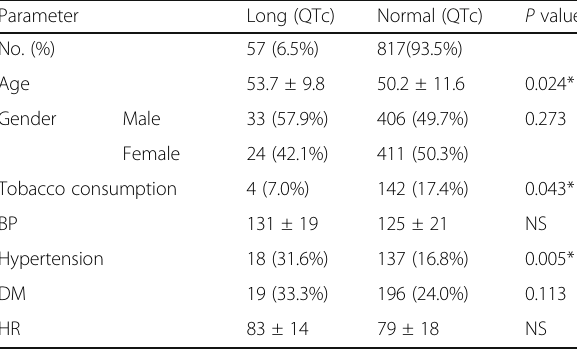
Table 1 Baseline characteristics of the studied patients